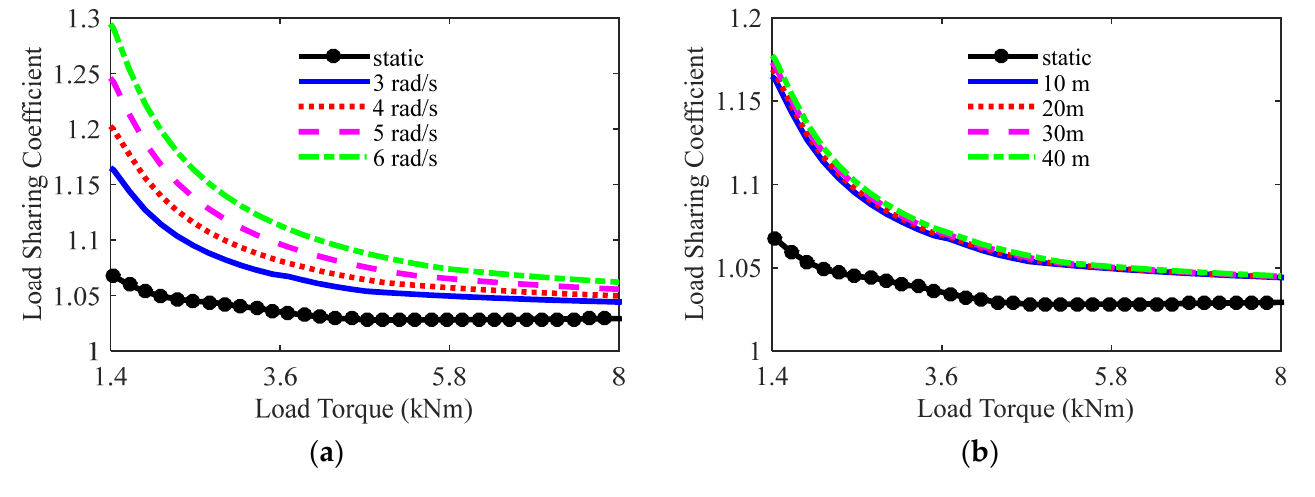
Figure 20. Influence of load torque on LSC under loop maneuver. ( a ) At different LAV; ( b ) At different LR.